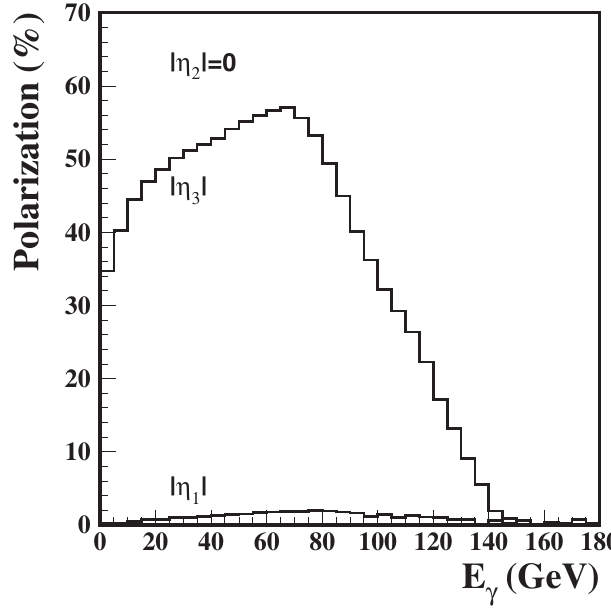
FIG. 2. Theoretical calculation of the polarization for 178 GeV photon beam for the radiator conditions mentioned in the